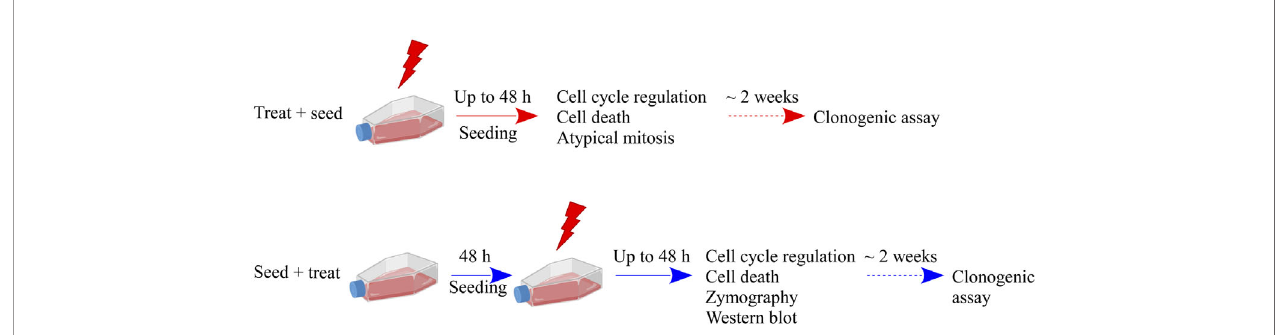
FIGURE 1 | Schematic illustration of the experimental protocols and summary of investigated endpoints. Results presented in this work are obtained with two different experimental protocols: in the “ Treat + Seed ” protocol cells are fi rst irradiated and then immediately re-plated; in the “ Seed + Treat ” protocol cells are plated ~48 h before irradiation. In both protocols, cells are exposed to X-rays (doses: sham irradiation at 0 Gy, 2, 5 and 10 Gy) and several endpoints are measured at different time points (6, 24 and 48 h) from the exposure. Cell clonogenic potential is assessed at ~ 14 days from the exposure. Part of illustration created